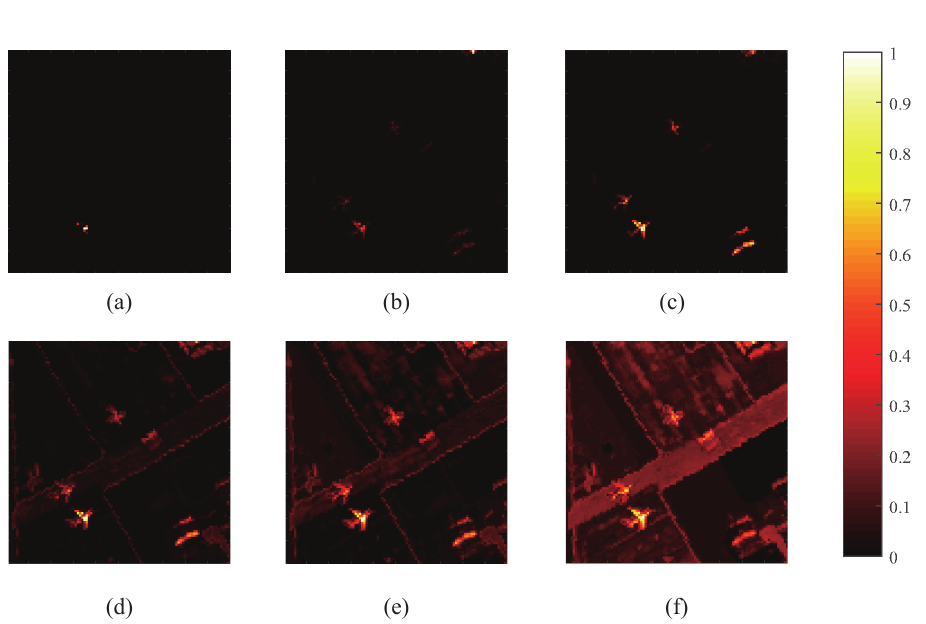
Figure 12. The detection maps with different settings of α for the San Diego airport dataset.